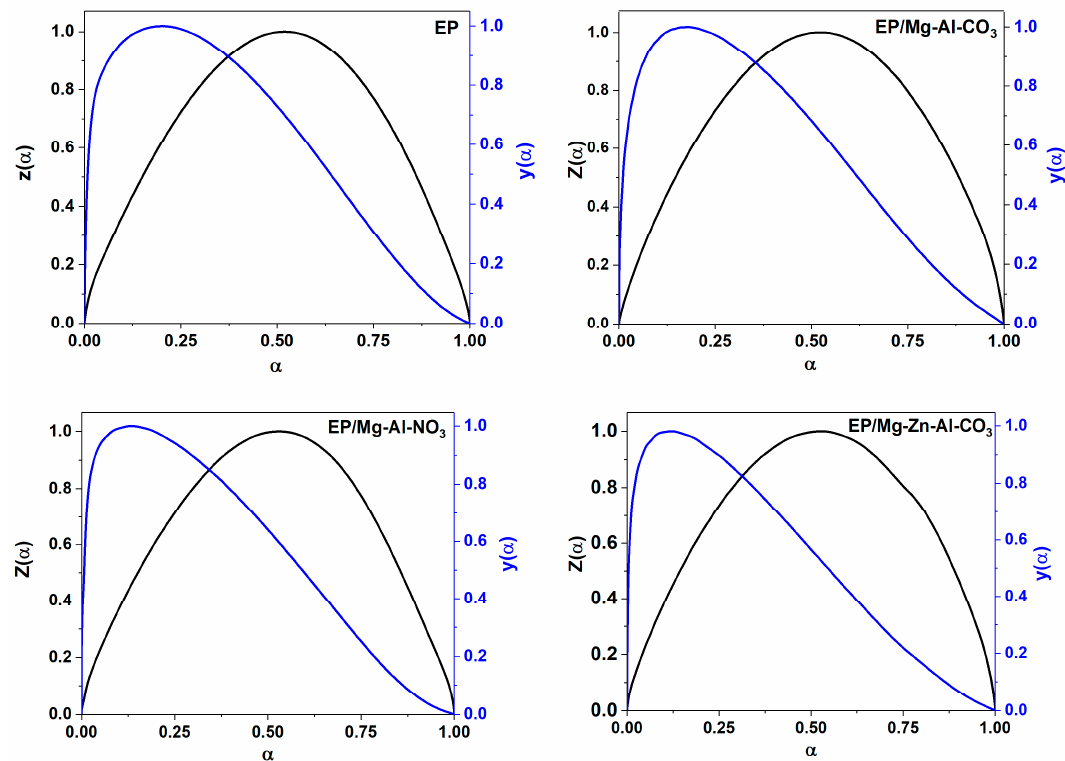
Figure A5. Variation of y( α ) and z( α ) versus conversion for the prepared samples based on the Málek model.